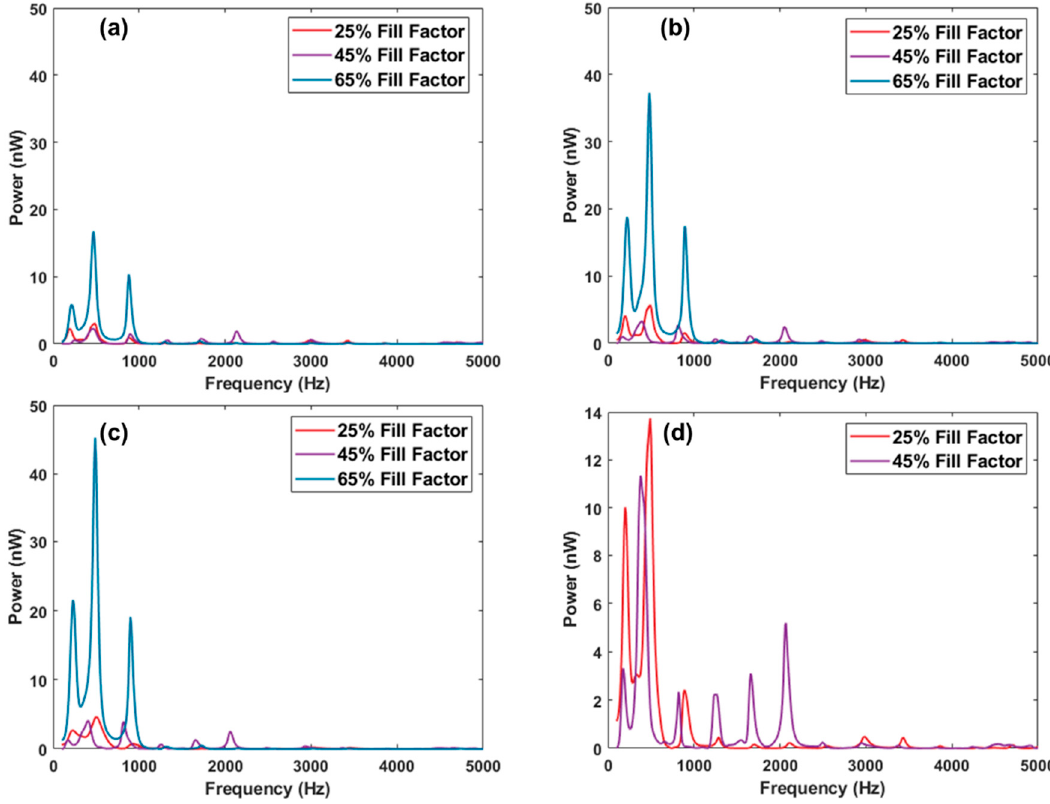
Figure 3. Power generated by the PZT samples for a load resistance of ( a ) 510 Ω , ( b ) 1 k Ω , ( c ) 1.5 k Ω , and ( d ) 2 k Ω .